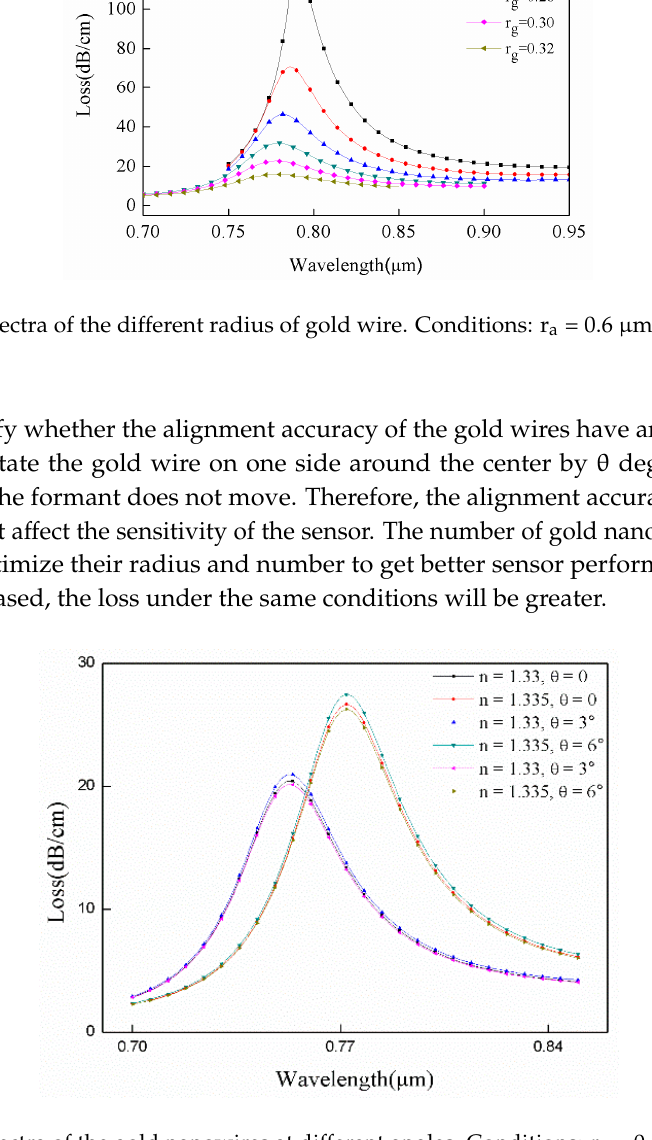
and n = 1.34. and n =